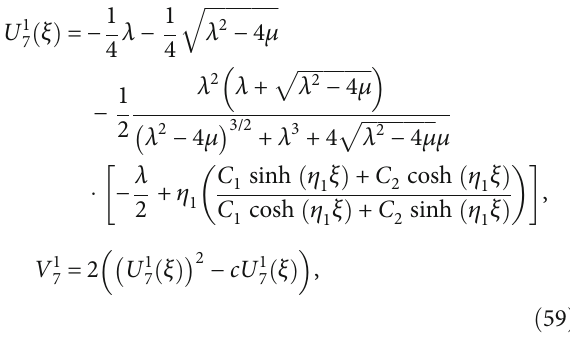
p 4 μ − λ 2 , and ffiffiffiffiffiffiffiffiffiffiffiffiffiffiffi λ 2 − 4 μ ffiffiffiffiffiffiffiffiffiffiffiffiffiffiffi p λ 2 − 4 μ